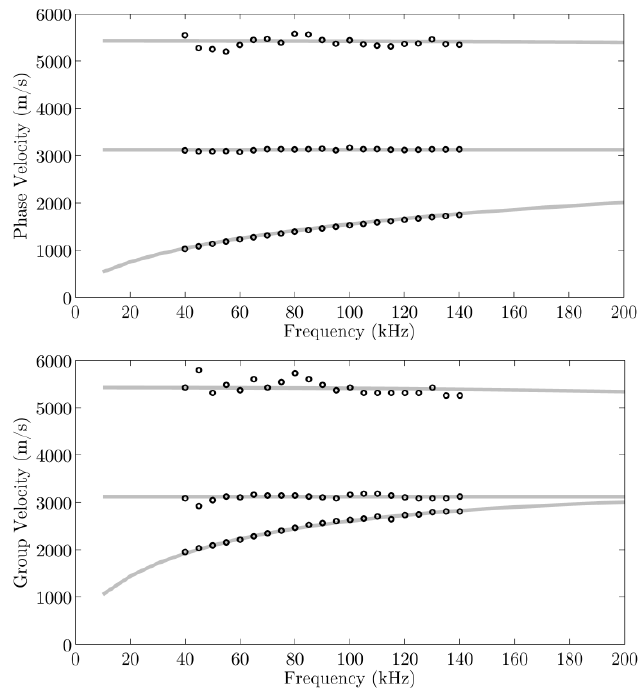
Figure 14. Phase velocity and group velocity created from experimental signals for 5 cm propagation distance (black circles) and theoretical values (grey lines). Appl. Sci. 2018 , 8 , x FOR PEER REVIEW